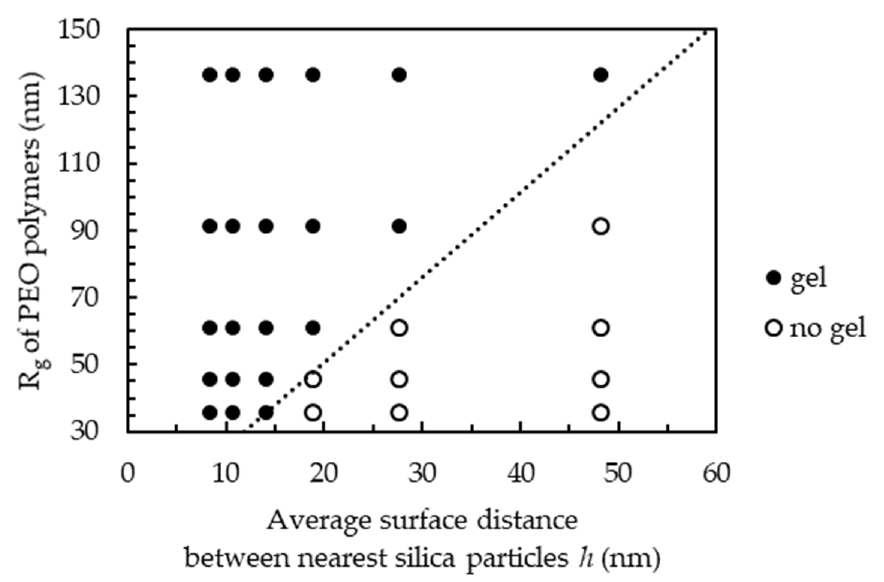
Figure 3. The state diagram of silica-PEO suspensions with various molecular weight PEOs and concentrations of silica. C p was fixed to 0.04 mg · m − 2 . The average distance of silica and the R g of PEO were calculated according to the silica concentration (5, 10, 15, 20, 25, 30 wt%) and the PEO molecular weight. The borderline is around R g = 2.5 h , indicating that the cause of gelation is the bridging effect.